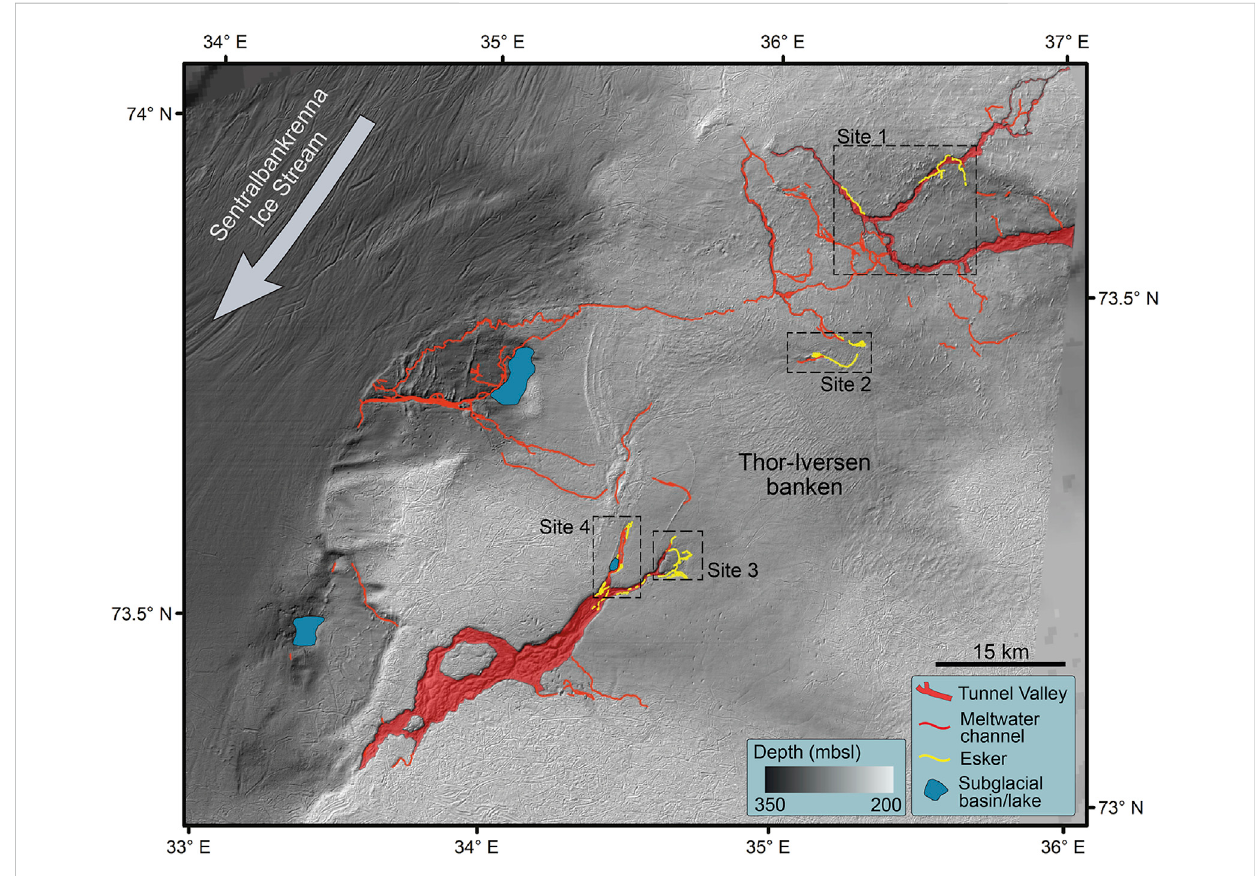
FIGURE 10 Mapped subglacial drainage features over Thor Iversen-banken, with landforms presented and mapped in this study merged with those from previous studies (Bjarnadóttir et al., 2017; Esteves et al., 2017; Newton and Huuse, 2017).